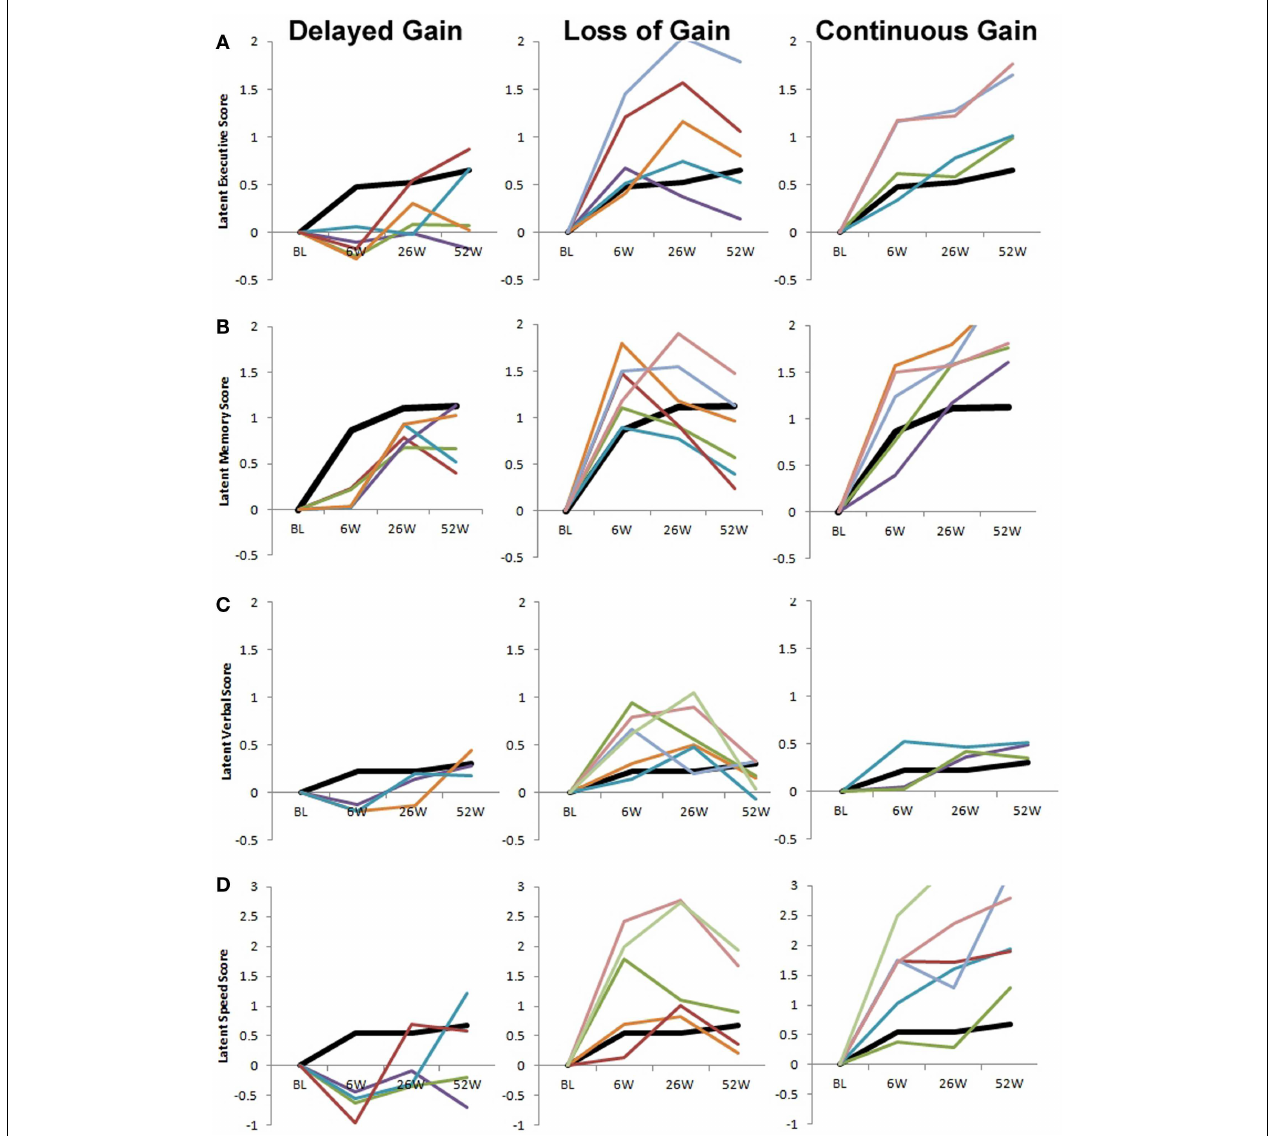
221, and 222) that show continued gain throughout the first year of recovery. For each panel, data from one individual in each trajectory group are shown. Some trajectories were not observed for each latent factor (see Table 1 ).To maintain consistency in scale across panels, some trajectory examples include data points outside of the y -axis range (e.g., the latent memory and speed, continuous gain group). Note that the scale of latent scores is different for the speed factor (D) versus all other factors. BL, baseline/treatment entry; 6W, 6-week follow up; 26W, 26-week follow up; 52W, 52-week follow